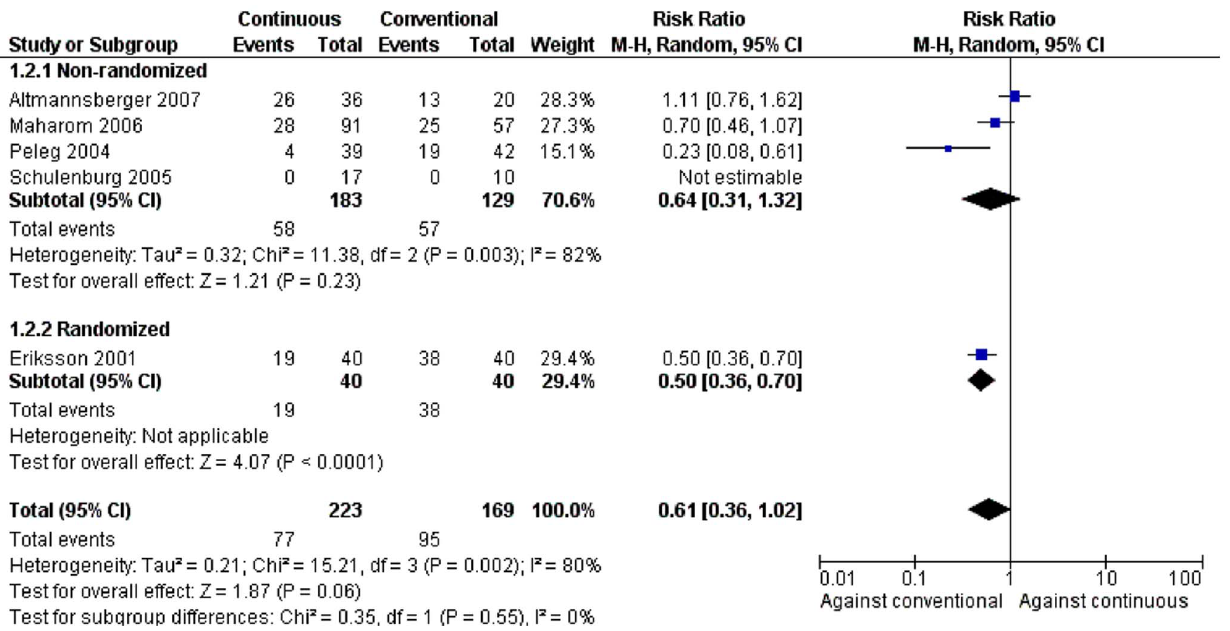
Figure 2. Forest plot depicting the risk ratios (RR) of nephrotoxicity for patients receiving continuous versus conventional infusion of amphotericin B deoxycholate, stratified by non-randomized and randomized studies. (Vertical line=‘‘no difference’’ point between the two regimens. Squares=risk ratios; Diamonds=pooled risk ratios for all studies. Horizontal lines=95% confidence intervals).